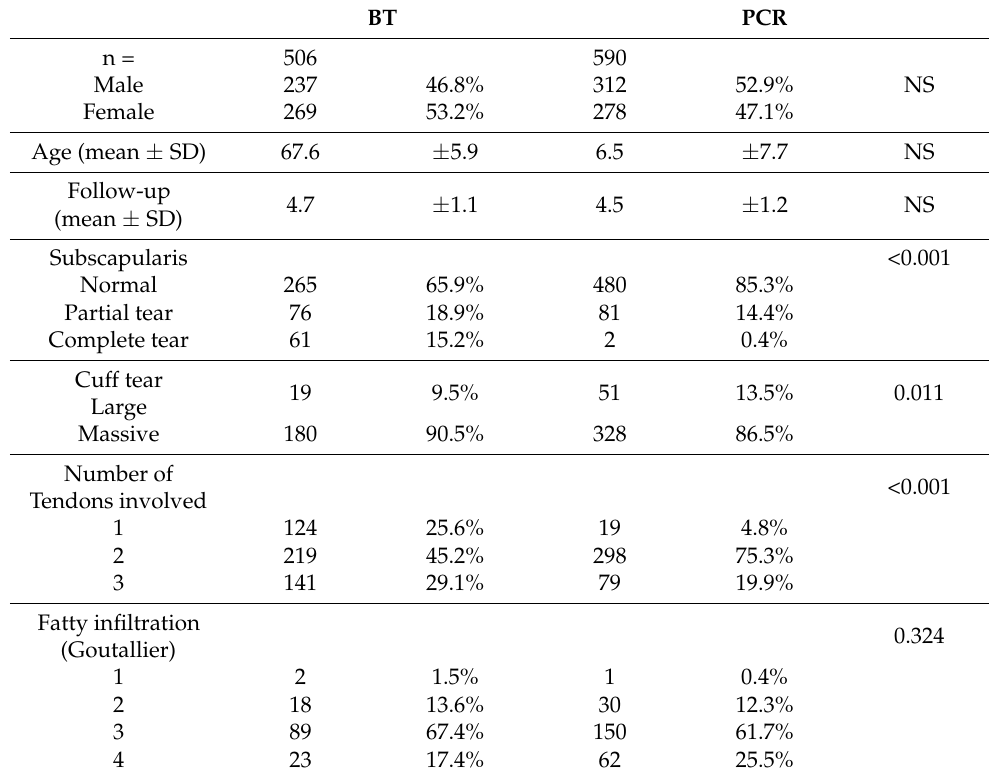
Table 1. Comparison between the groups BT and